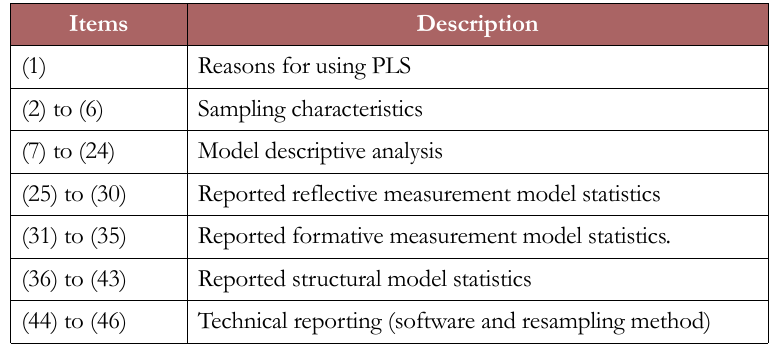
Table 2. Number of items reviewed by Kaufmann and Gaeckler